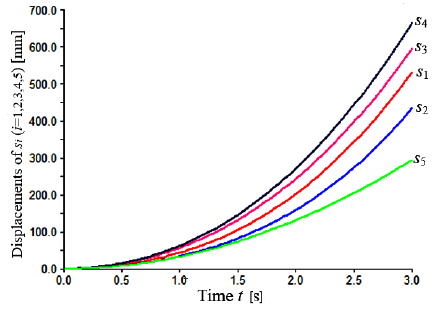
GHMT obtained from ADAMS